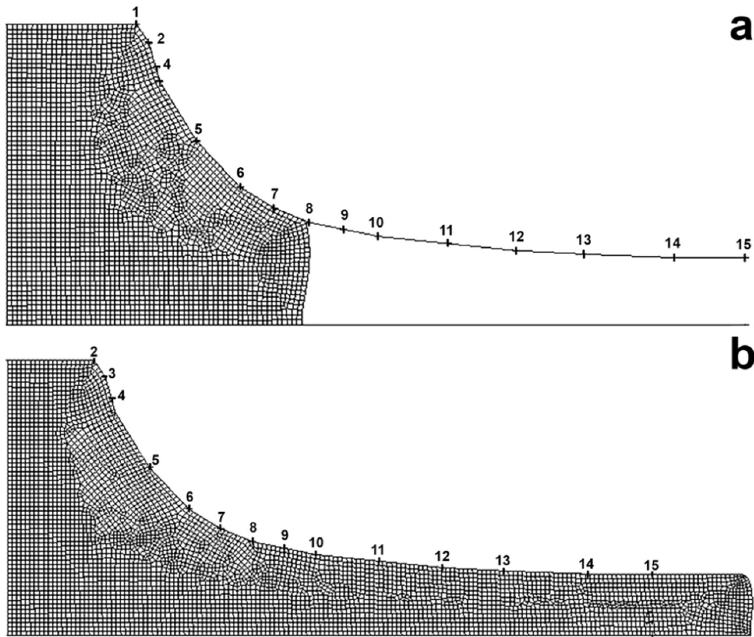
Figure 3. Lagrange mesh and specimen shape vs. time t, s: ( a ) 90, ( b ) 150.